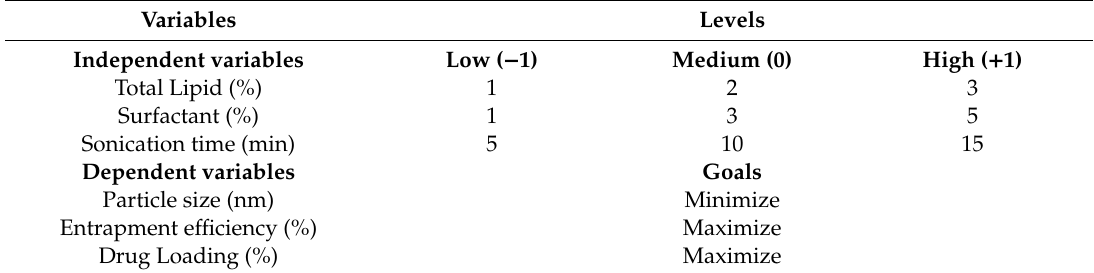
Table 2. Di ff erent levels and goals for the variables in the Box–Behnken design. Variables Levels Independent variables Low ( − 1) Medium